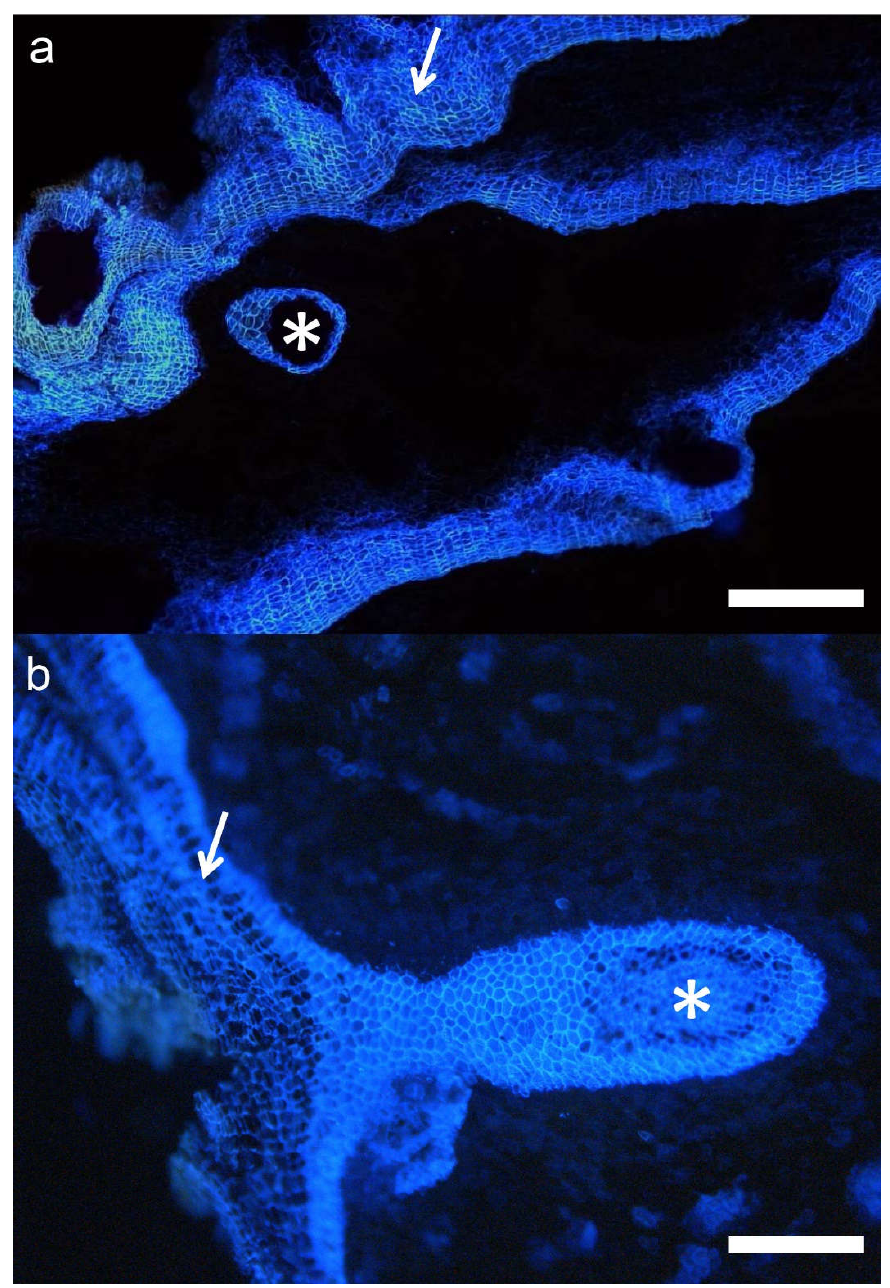
Figure 8. Cross section of the bark of a hybrid tree under UV light. ( a ): A closed thin periderm surrounding a schlerenchymatic nodule (asterisk) can be appreciated. Bar: 100 μm ( b ): A similar structure, connected to the normal periderm (arrow). Bar: 50 μm.